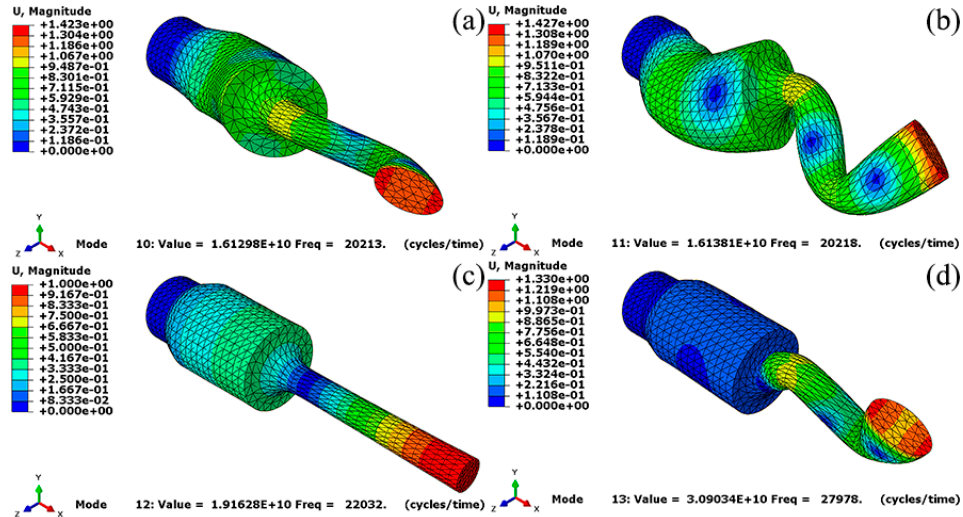
Figure 6. Cloud diagram of horn vibration mode of the 10–13 modes after the large end was increased 1 mm, ( a ) 10 mode, ( b ) 11 mode, ( c ) 12 mode, ( d ) 13 mode.